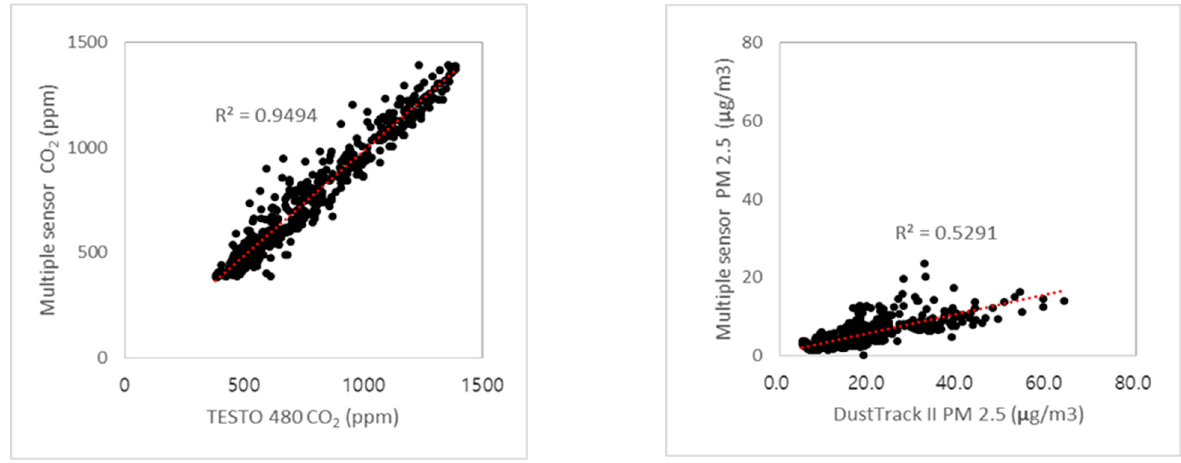
Figure 3. Measured CO 2 and PM 2.5 concentrations compared to the data from the TESTO 480 (CO 2 ) and the DustTrack II 8532 (PM 2.5 ) sensors, respectively.